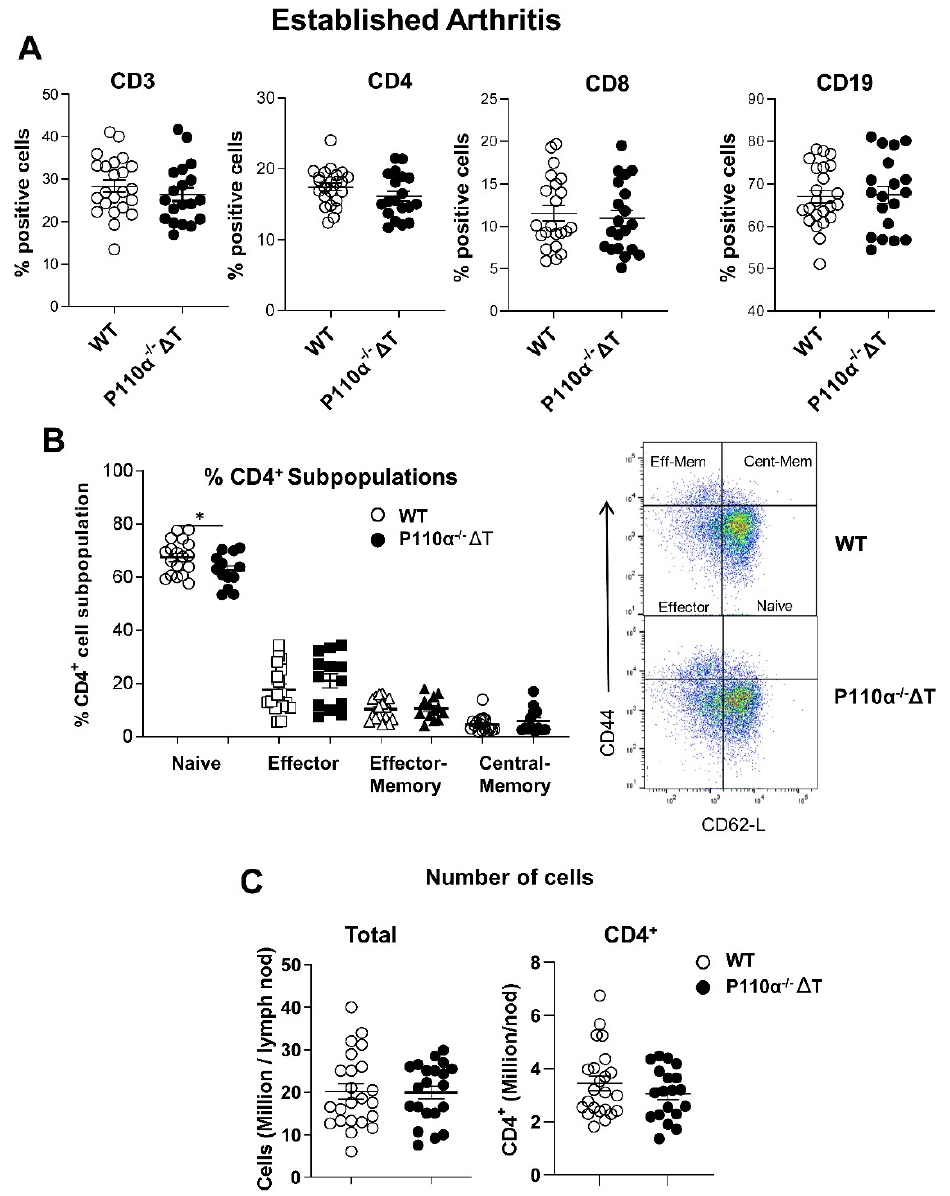
Figure 4. Analysis of T-cell subpopulations in the lymph nodes of p110 α − / − ∆ T mice under estab- lished CIA (long-term experiments). ( A ) Percentage of CD3 + , CD4 + , CD8 + and CD19 + lymphocyte subpopulations were analyzed by flow cytometry in the lymph nodes cells of WT and p110 α − / − ∆ T mice. ( B ) Percentage of naive, effector and memory CD4 + T cells, based on CD62-L and CD44 ex- pression (left). Representative dot-plots showing the expression of CD44 and CD62-L in gated CD4 + T cells and the distribution of naive, effector and memory subpopulations are shown (( B ), right). ( C ) The number of total (left) or CD4 + (right) cells per draining lymph node of WT and p110 α − / − ∆ T mice were calculated and are represented. ( A , C ), n = 23 for WT and n = 20 for p110 α − / − ∆ T mice; ( B ) n = 18 for WT and n = 13 for p110 α − / − ∆ T mice. * p < 0.05. Open symbols, WT mice; closed symbols, p110 α − / − Δ T mice. Data show the mean ± SEM from individual mice ana- lyzed.